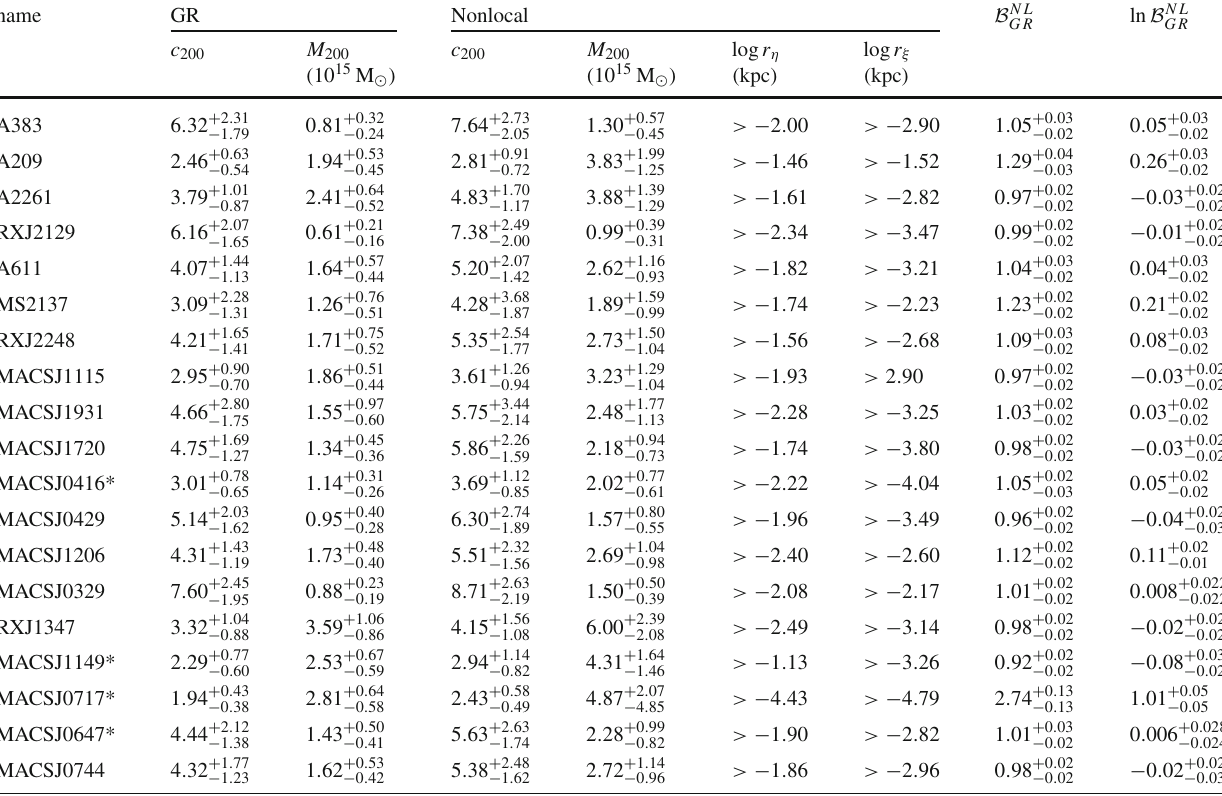
Table 1 CLASH clusters ordered by redshift. For each cluster, we provide 1 σ constraints on each parameter in the top line, and the minimum values in the χ 2 function in bottom one. Units: cluster radii are in kpc. Lensing-selected CLASH clusters are indicated by